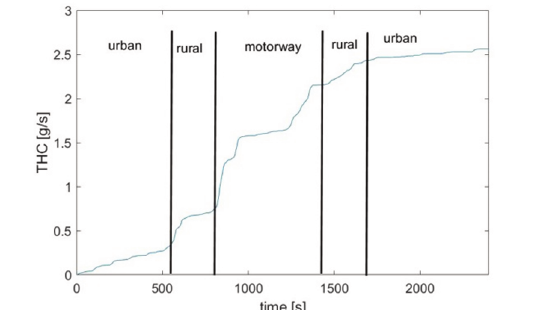
Fig, 9. Emission of THC for Euro 6 petrol fuelled vehicle